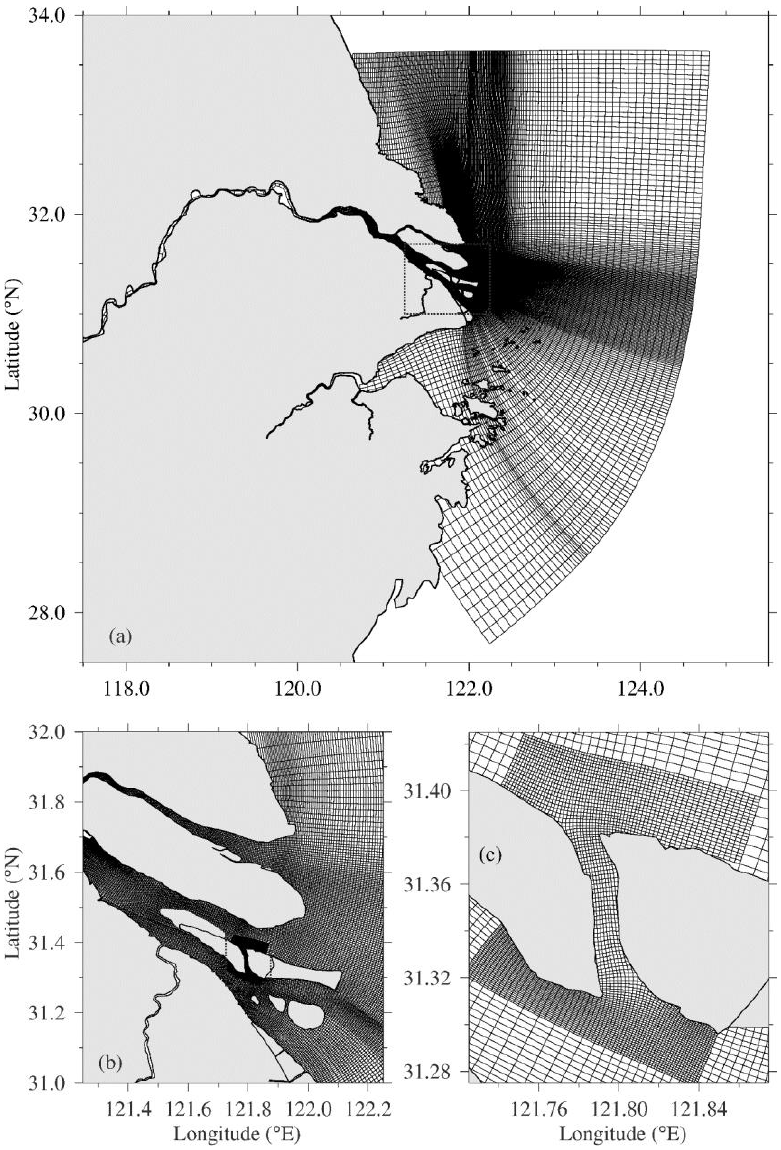
Figure 4. Model domain and unstructured grid ( a ), closeup of the grid around the Chengjiang Estuary ( b ), and enlarged view of the grid around the HC ( c